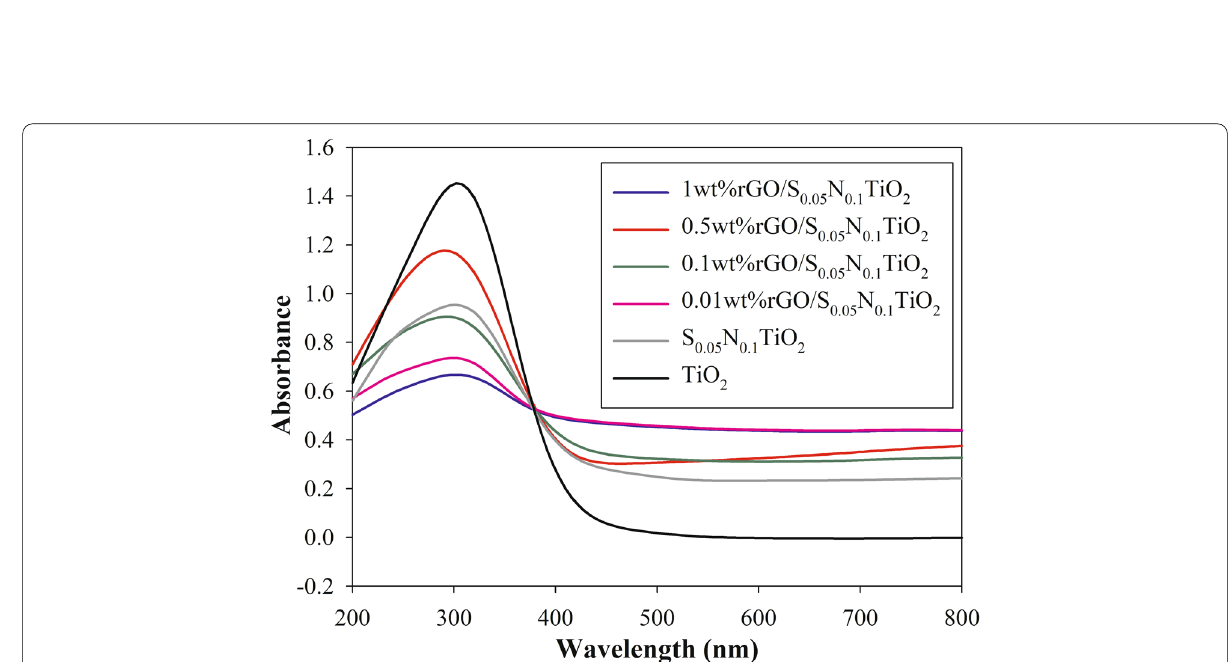
Fig. 5 Absorbance spectra of various synthesized